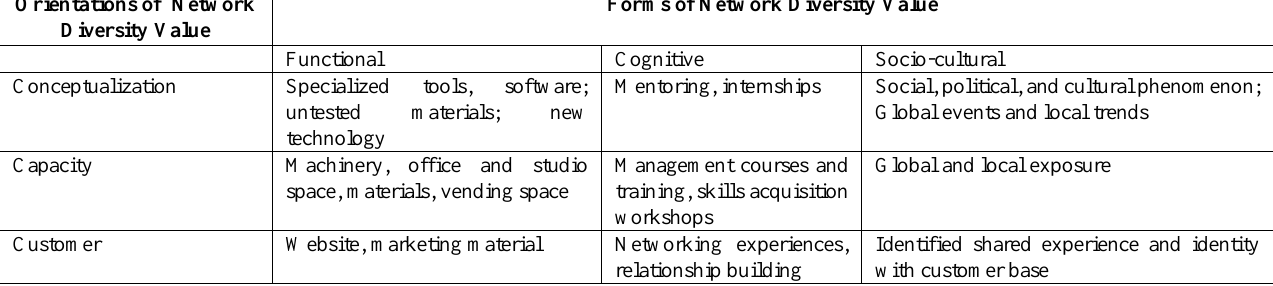
Table 1: Network diversity value framework Orientations of